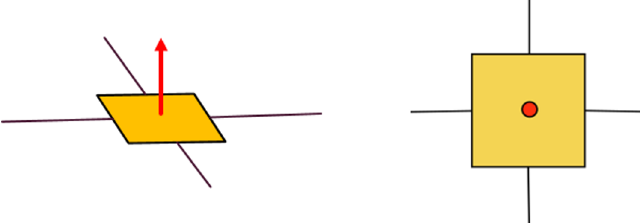
Figure 6. The tensor network representation of a Bacon-Shor code (or the multicopy stacked Bacon-Shor code which we will define later on). The (red) arrow/dot denote the single logical qubit that it encodes, and the four in-plane legs (black) denote the physical